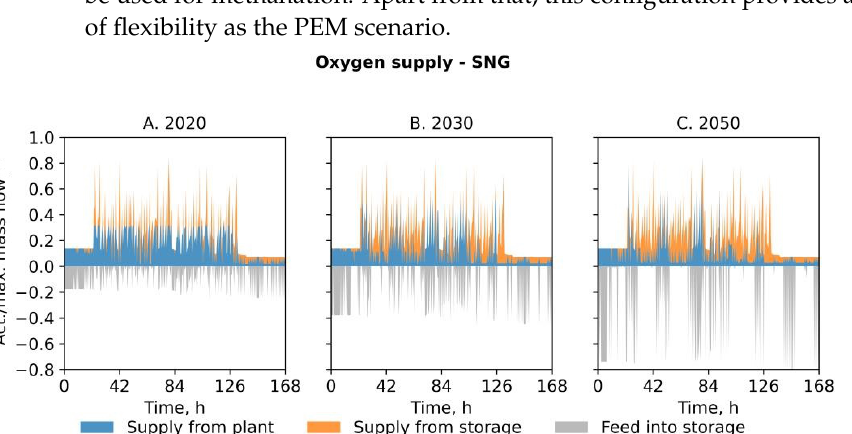
and oxygen production in the years 2020 ( A ), 2030 ( B ) and 2050 ( C ). be used for methanation. Apart from that, this configuration provides a comparable de-